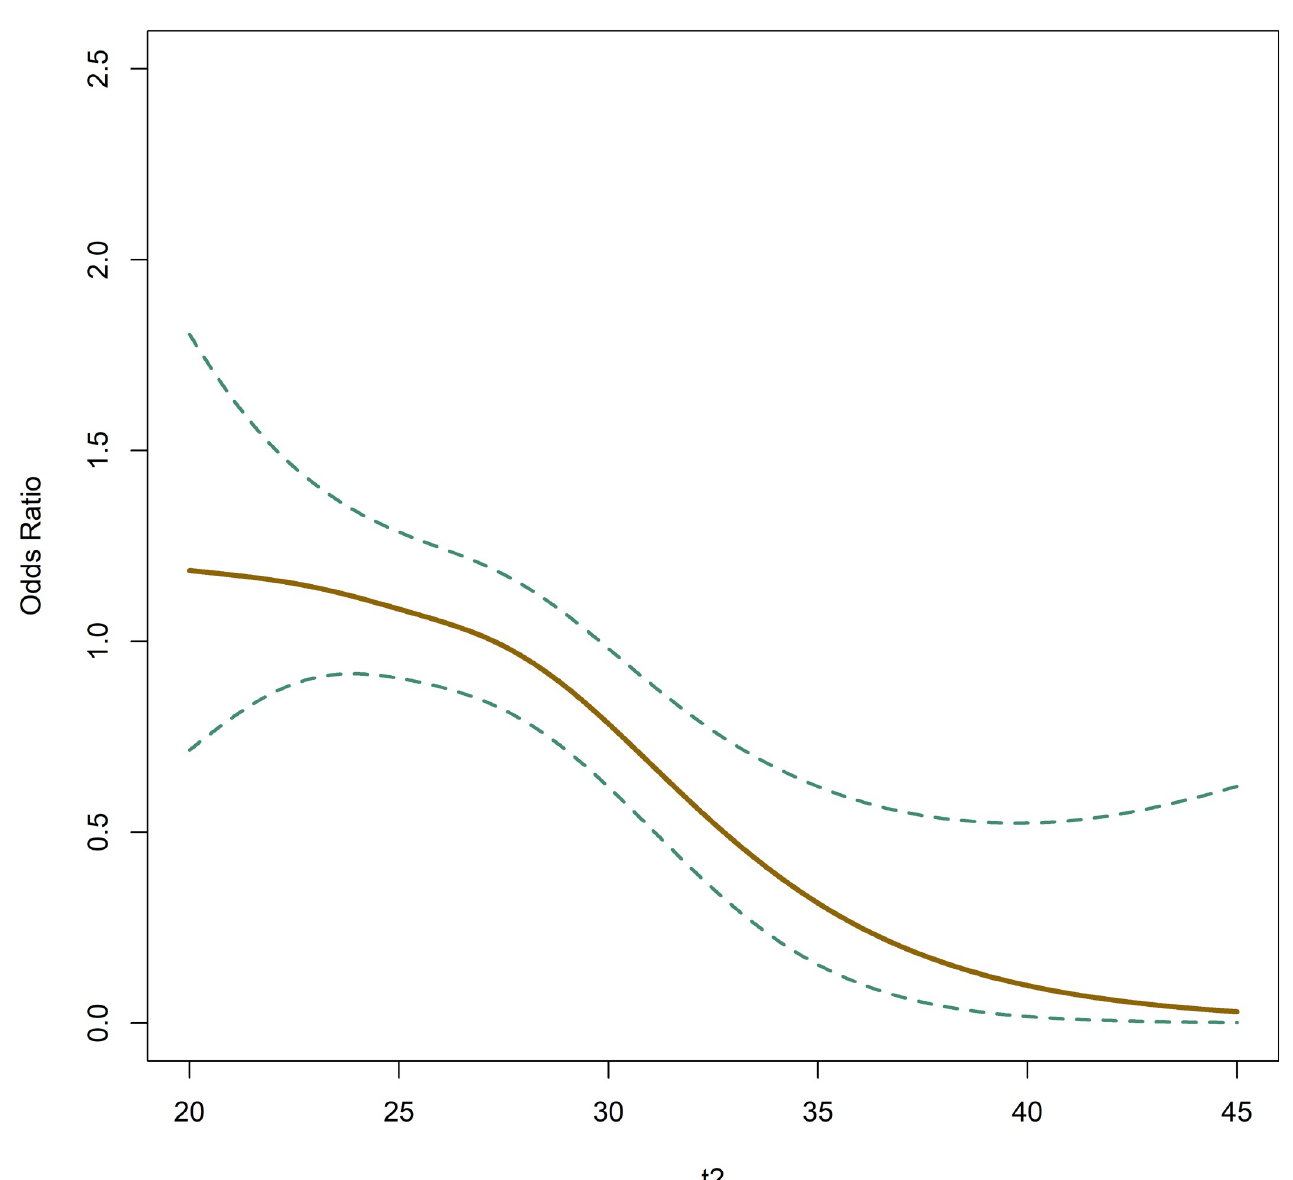
Fig 4. Odds ratio regarding live birth relative to t2 (first cell division, hours after insemination). Dashed lines show the 95% confidence interval (CI).